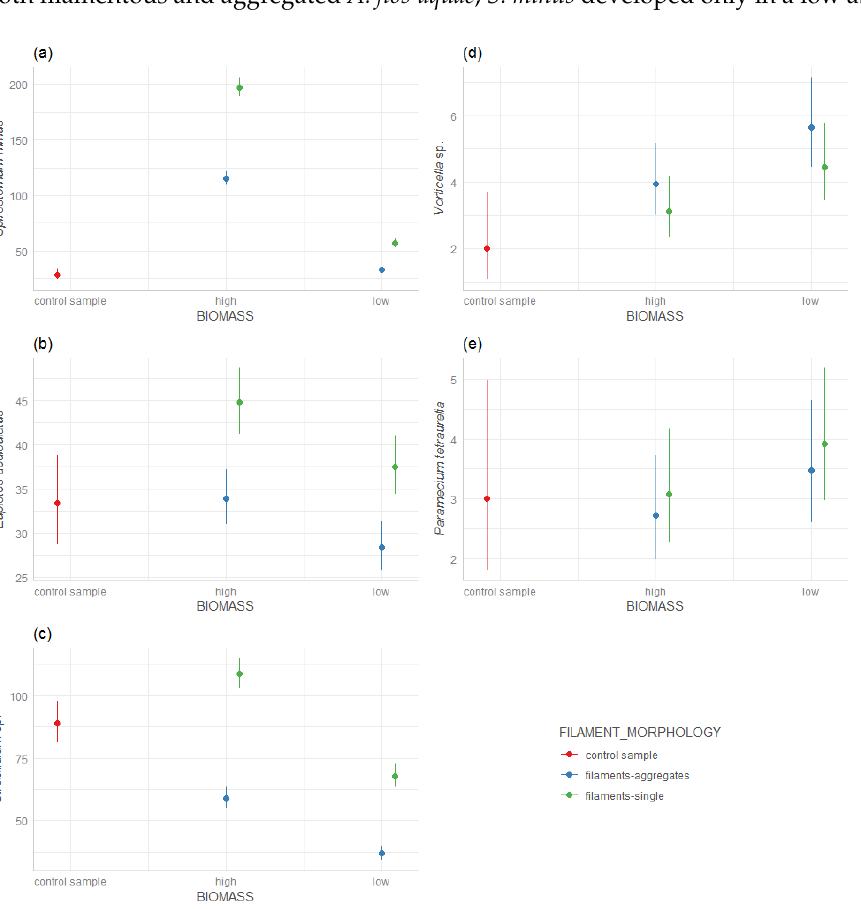
Figure 1. Response of ciliate species density on A. flos-aquae biomass (‘high’/‘low’) and filaments morphology (single filaments/aggregates): ( a ) Spirostomum minus , ( b ) Euplotes aediculatus , ( c ) Stro- bilidium sp., ( d ) Vorticella sp., ( e ) Paramecium